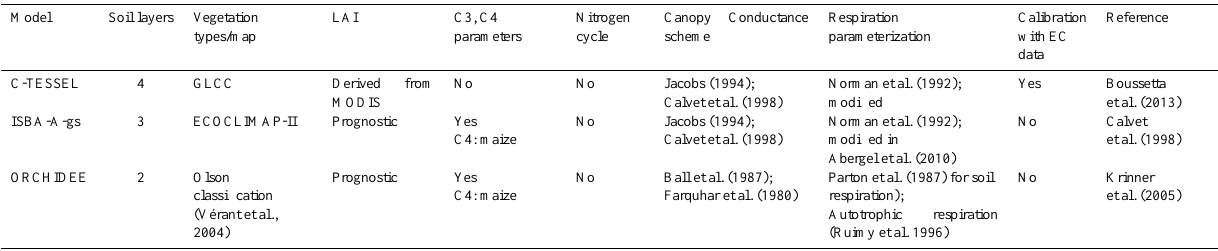
Table 2. List of models and characteristics and references. Model Soil layers Vegetation